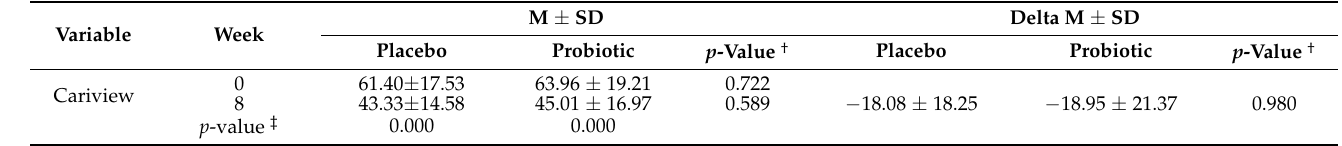
Table 2. Changes in the Cariview scores of the two groups at weeks 0 and 8 ( n = 68).